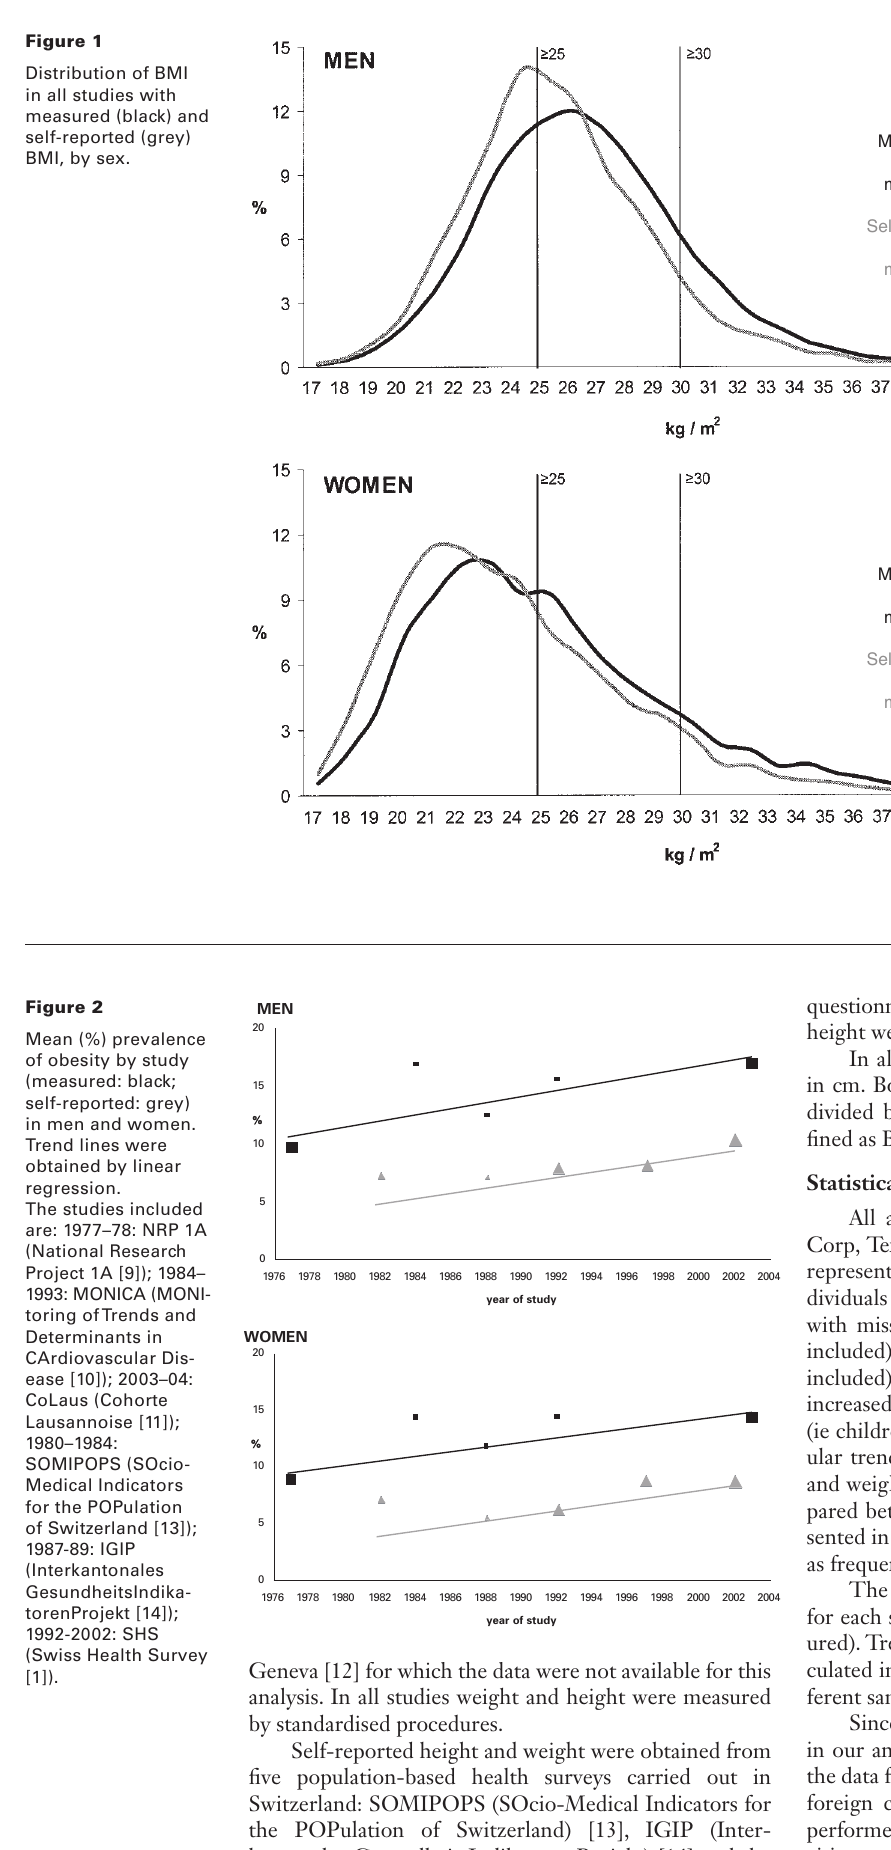
Figure 1 Distribution of BMI in all studies with measured (black) and self-reported (grey) BMI, by sex.